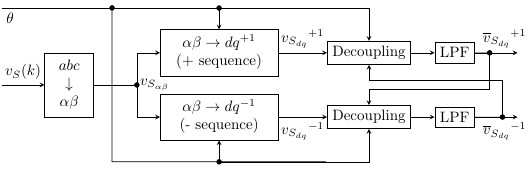
Figure 25. Block diagram of DDSRF-PLL